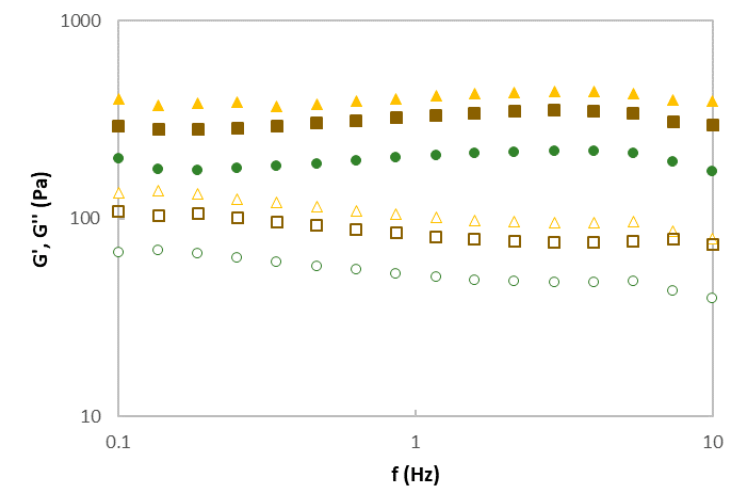
Figure 3. Mechanical spectra of gelatin-based hydrogels supplemented with selected Paulownia extracts processed at the lowest autohydrolysis conditions (140 °C). Symbols: G ′ (closed), G ′′ (open), bark (squares), leaves (circles), petioles (triangles).